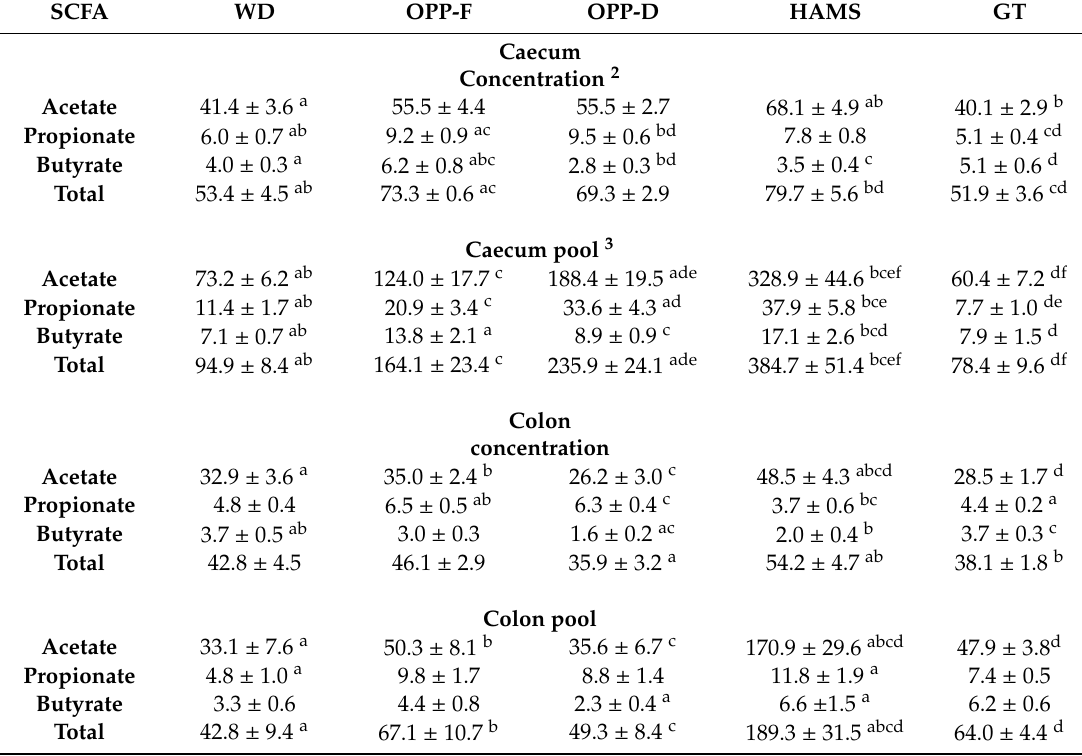
Table 3. E ff ects of dietary treatment on individual and total SCFA in caecal and colonic digesta 1 . SCFA